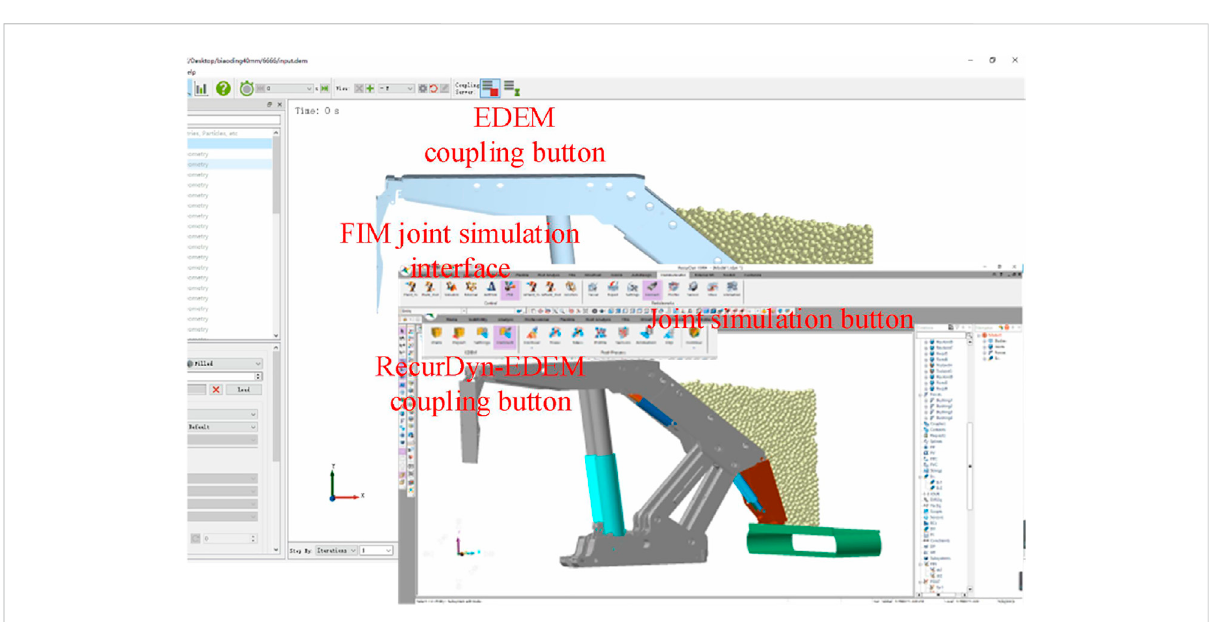
FIGURE 6 RecurDyn – EDEM bi-directional coupling simulation